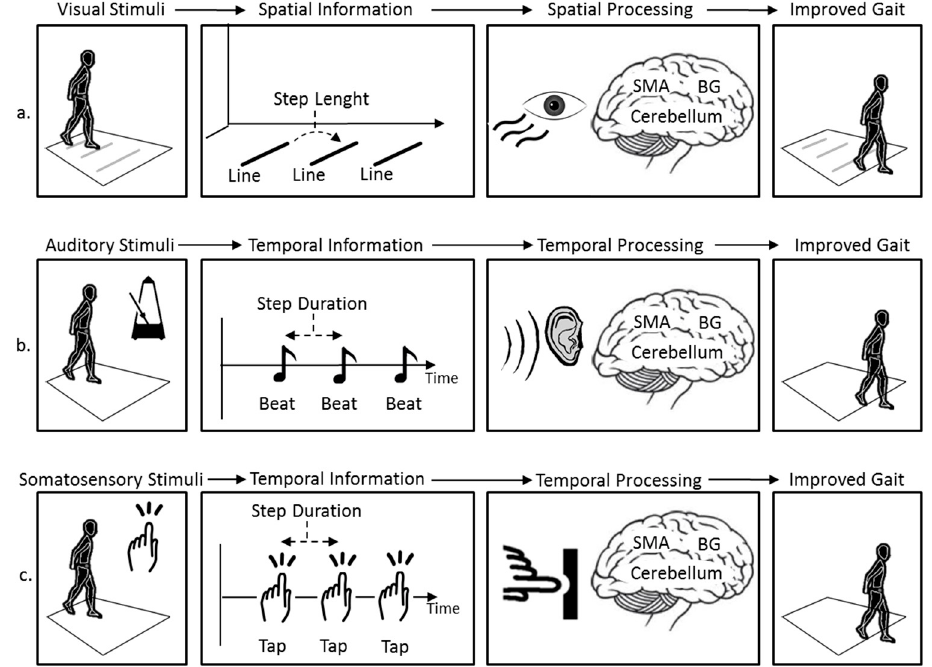
Figure 1. Three cueing modalities to ameliorate FoG. ( a ) Visual cueing: parallel lines marked on the ground at a fixed distance apart, conveys spatial information, such as step length; ( b ) Auditory cueing: a metronome producing auditory stimuli at a set beat, conveys temporal information, such as step duration; ( c ) Somatosensory cueing: Tapping of a people with Parkinson’s (PwP) shoulder at a set rhythm, also conveys temporal information, such as step duration. Both spatial and temporal information may be perceived by PwP and processed through multiple brain regions (BG—basal ganglia, SMA—supplementary motor area and cerebellum) to ameliorate FoG and improve gait.